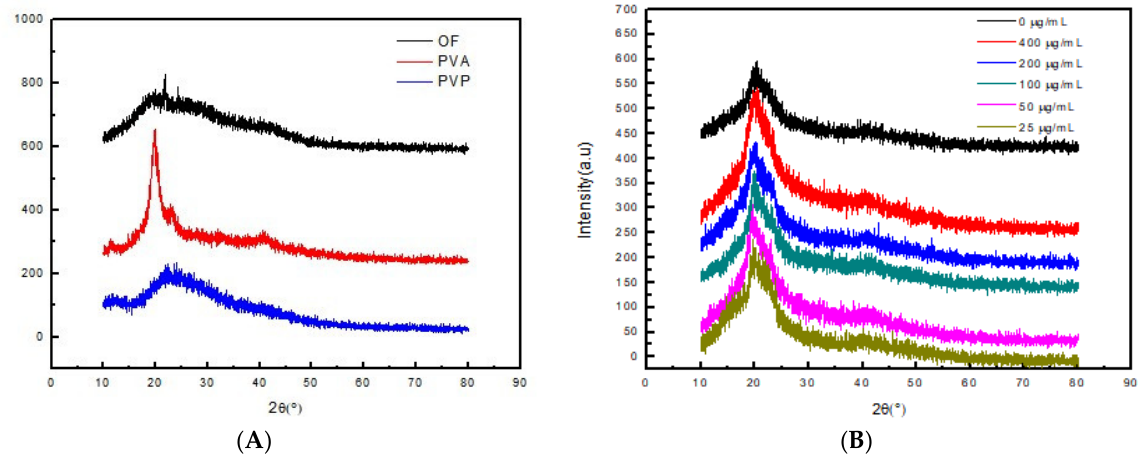
Figure 2. X-ray diffraction patterns of osmanthus extract, PVA, PVP and OF/PVP/PVA hydrogel ( A ): X-ray diffraction patterns of osmanthus extract, PVA, and PVP; ( B ): X-ray diffraction patterns of OF/PVP/PVA hydrogels with different concentrations of osmanthus extract.